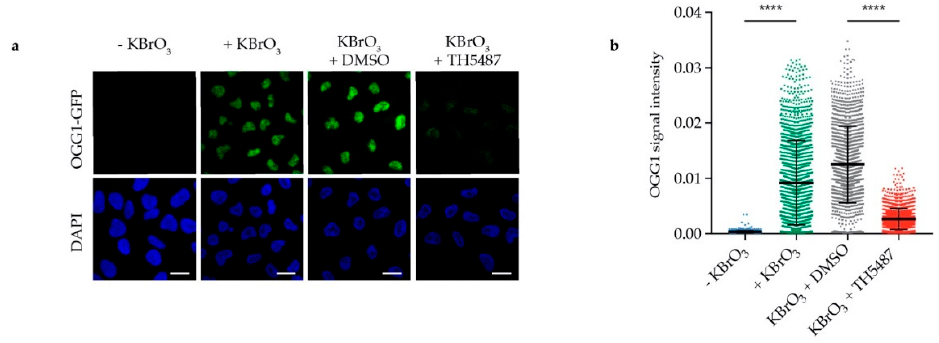
Figure 3. TH5487 treatment affects OGG1 retention in cells exposed to oxidative stress. ( a ) OGG1–chromatin binding. Representative confocal images of U2OS cells after in situ extraction. Scale bar: 20 μ m. ( b ) Fluorescence signal intensity of retained OGG1-GFP. U2OS cells were exposed to the indicated treatment conditions, then in situ extraction with 0.1% Triton for 1 min was performed prior to fixation with 4% paraformaldehyde. Scatterplot shows OGG1-GFP nuclear fluorescence signal intensity of at least 1300 cells for each treatment condition and mean fluorescence intensity ± SD of three independent experiments. Statistical significance was determined using unpaired two-sided t -test (**** P < 0.0001).